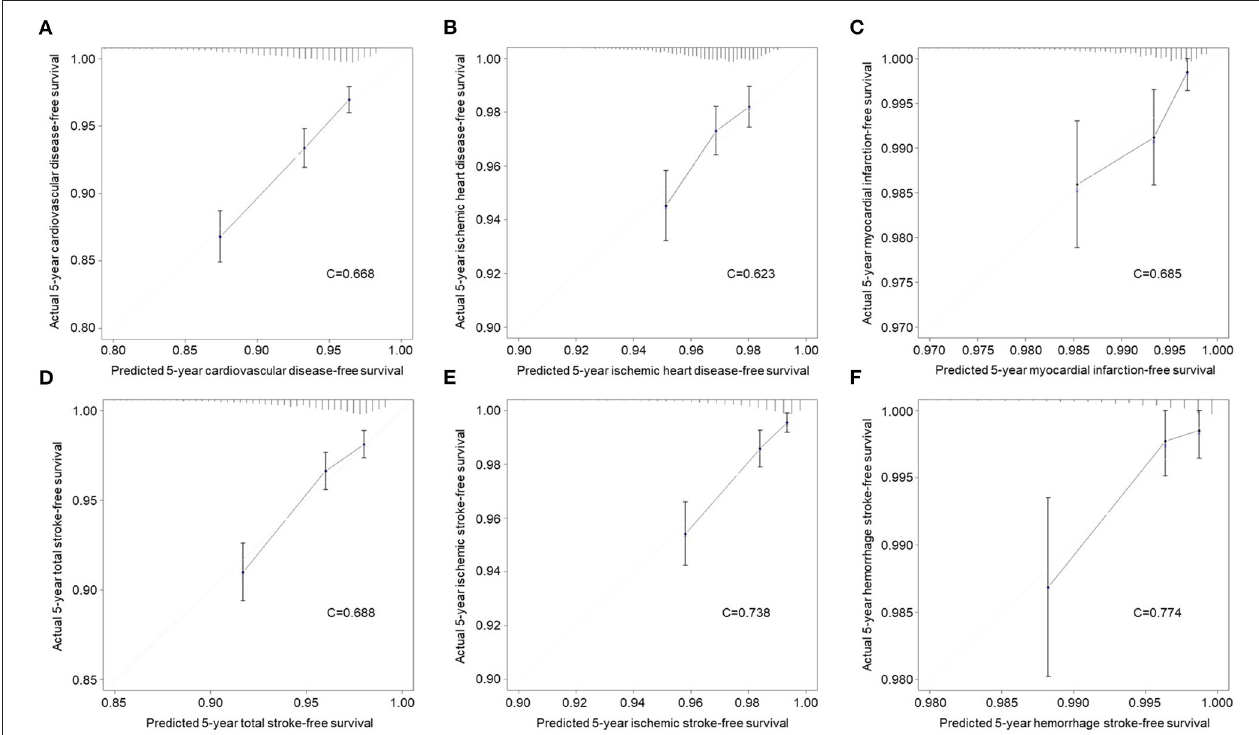
FIGURE 3 | Calibration curves for evaluation of consistency between actual and predicted risks of cardiovascular diseases in the validation cohort. (A) Overall cardiovascular disease. (B) Ischemic heart disease. (C) Myocardial infarction. (D) Total stroke. (E) Ischemic stroke. (F) Hemorrhage stroke.